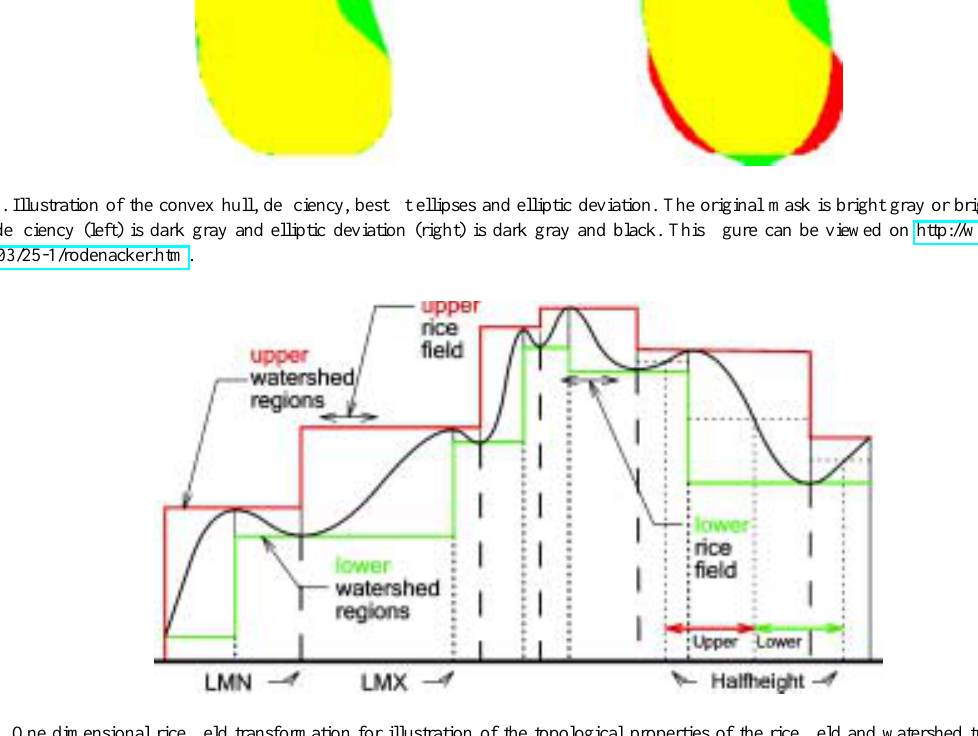
Fig. 11. One dimensional rice field transformation for illustration of the topological properties of the rice field and watershed transformation. This figure can be viewed on